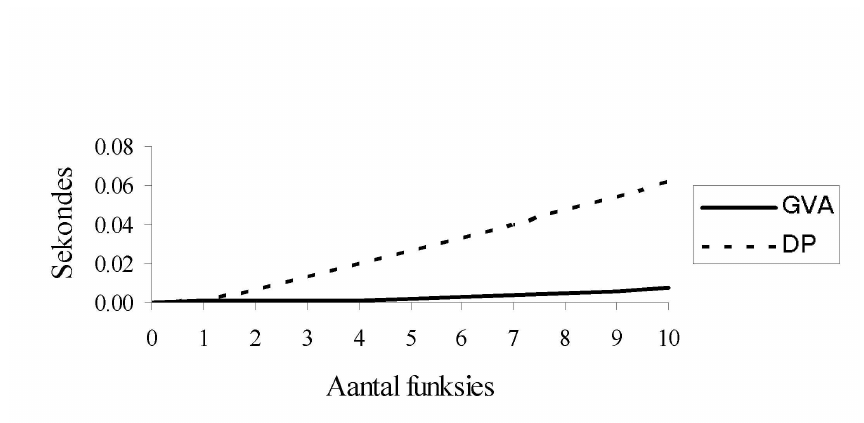
Figuur 1: Berekeningstyd met toename in aantal